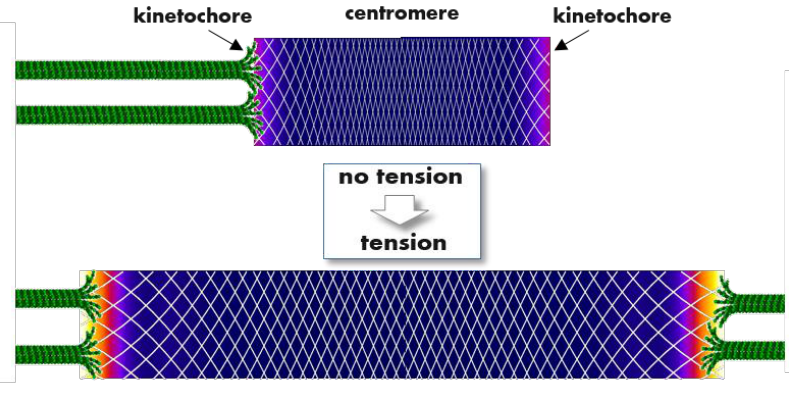
Figure 6. A molecular model to explain how tension regulates phosphorylation of kinetochore proteins that bind KMTs and regulate their attachment lifetime. Color-coded plots show the spatial distribution of active Aurora B kinase within a continuous flexible matrix (white mesh), encompassing the centromeric chromatin and two sister kinetochores (based on the theoretical model in [89]). Aurora B kinase is enriched strongly in the middle of the centromere (not shown), where it becomes highly active (purple and blue colors) due to trans-molecular auto-phosphorylation. With no tension this activity propagates from the centromere throughout the entire matrix, as active kinase “ignites” the nearby kinase, overcoming opposing phosphatases. As a result, kinase activity at the kinetochores is high